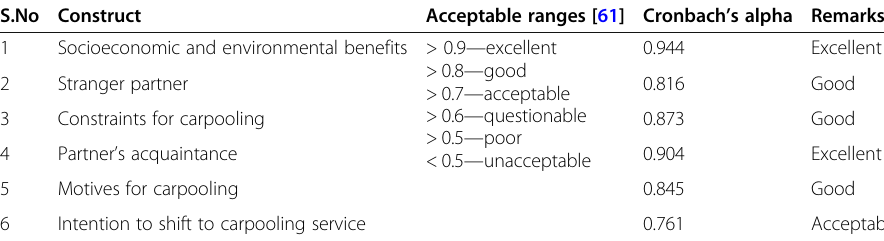
Table 3 Cronbach ’ s alpha values obtained from reliability analysis